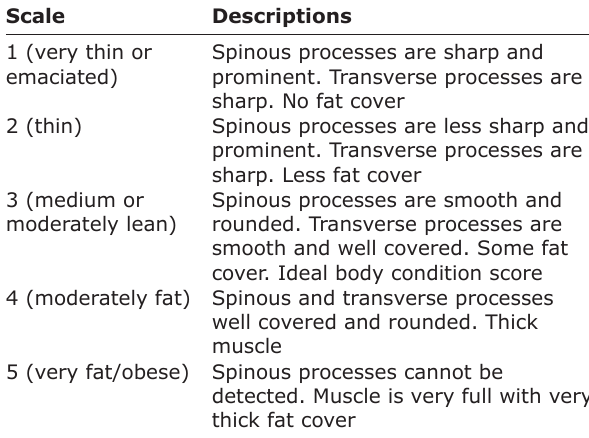
Table-2: Body condition score scale.